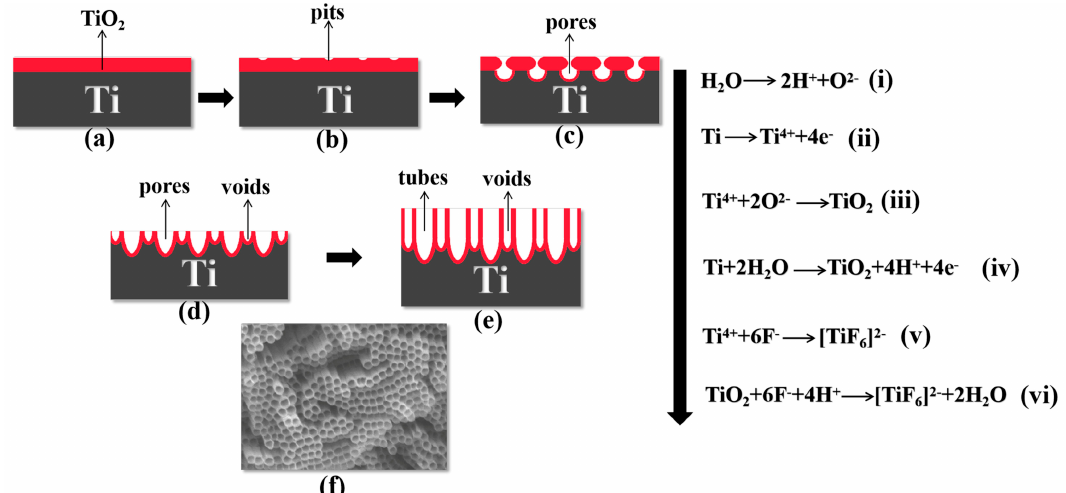
Figure 2. Schematic diagram of nanotube evolution at constant anodization voltage: ( a ) formation of TiO 2 barrier layer; ( b ) pits formed on the oxide layer; ( c ) pits growing into pores morphology; ( d ) pores’ growth and voids’ formation; ( e ) formation of TiO 2 nanotubes; ( f ) top view of fully grown TiO 2 nanotube arrays. Formulas (i)–(vi) are the chemical reactions that occurred during the anodic oxidation process.